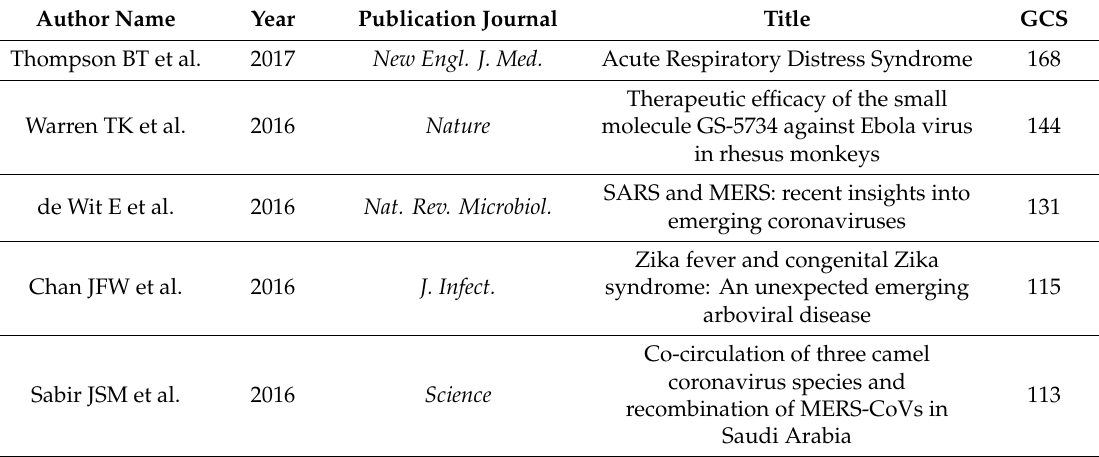
Table 10. Top cited papers with over 100 citations during 2016–2019.